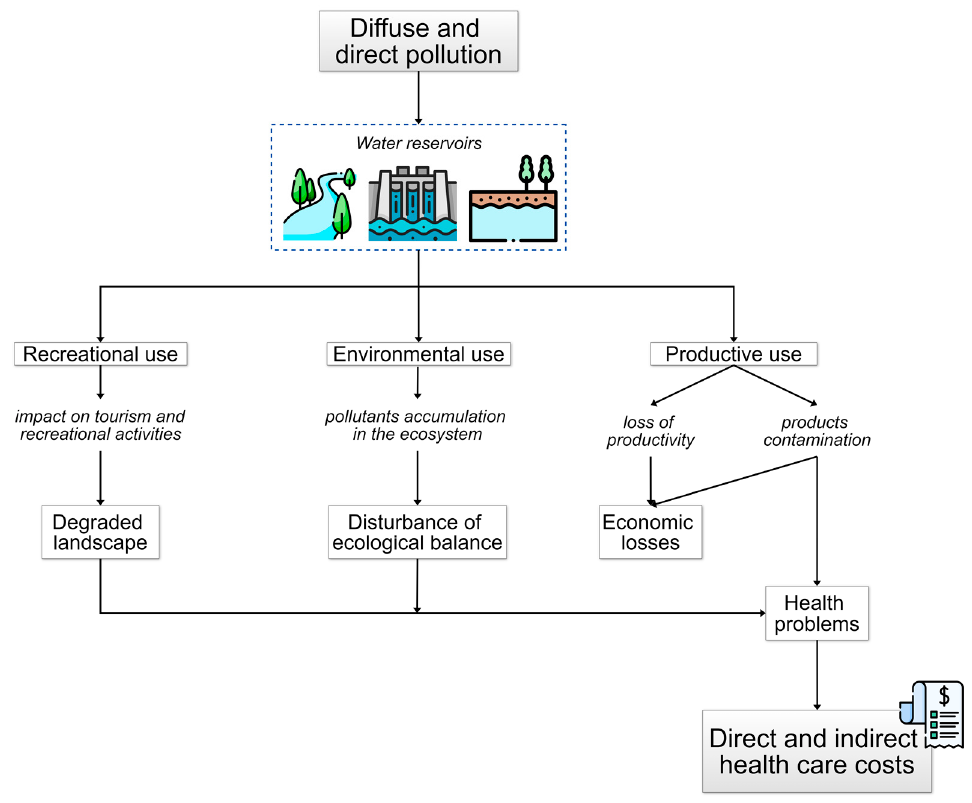
Figure 2. Relationship between impacts on water bodies with direct and indirect costs. Source: own elaboration.